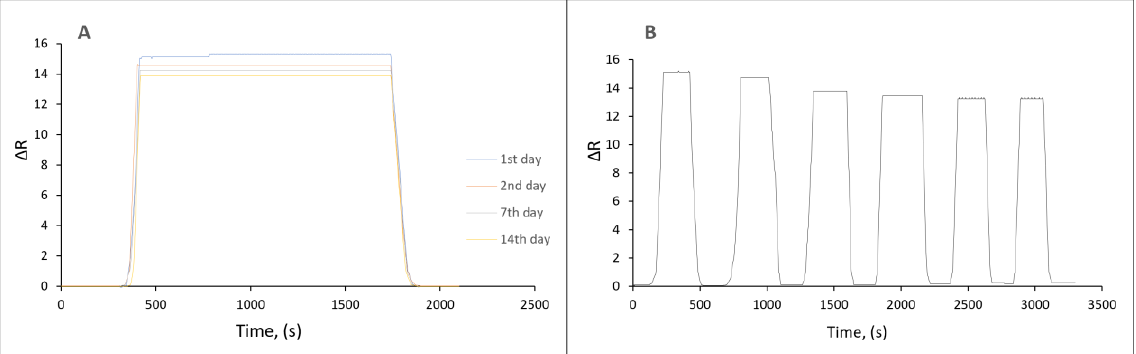
Figure 7. ( A ) Reusability of CIP-SPR nanosensor for coumaphos detection after fourteenth days (C: 100 ppb, pH 7.4, t: 25 °C). ( B ) Repeatability of CIP-SPR nanosensor for coumaphos detection after six measurements (C: 100 ppb, pH 7.4, t: 25 °C).